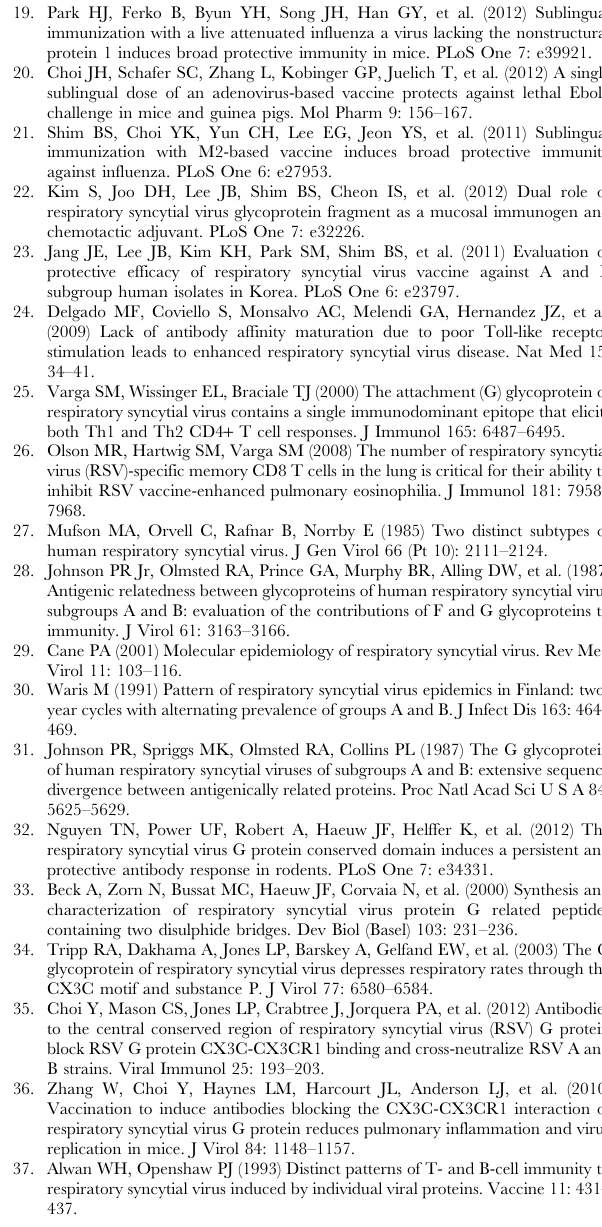
wtAGcf, mGcf, Th-mGcf, FI-RSV and live RSV. Mice were immunized twice with wtAGcf, mGcf, or Th-mGcf in the